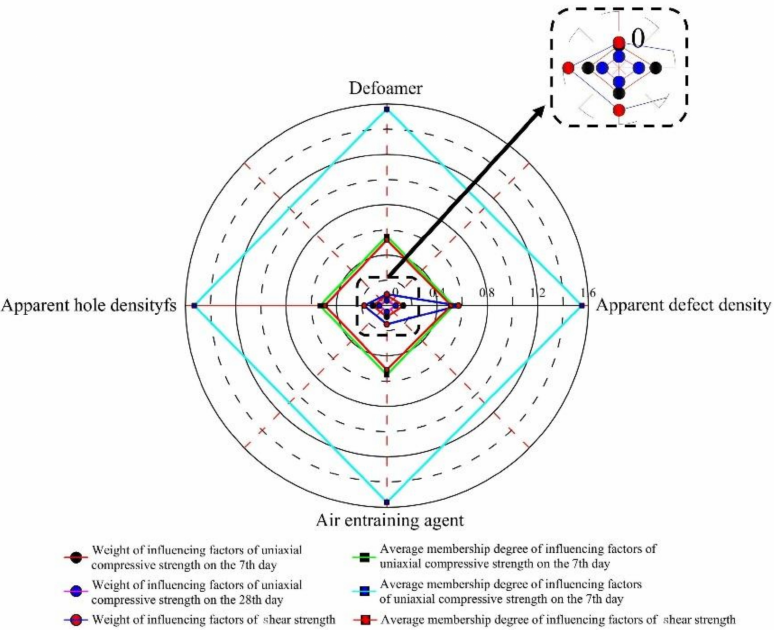
Figure 15. Radar chart of weight and average membership degree of each index of SCFFC strength. Table 6. Weight and average membership degree of factors affecting uniaxial compressive strength of SCFFC.